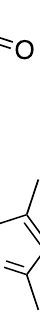
Figure 1. Fluorophore used in this work: para -maleimide BODIPY (p-MB) .